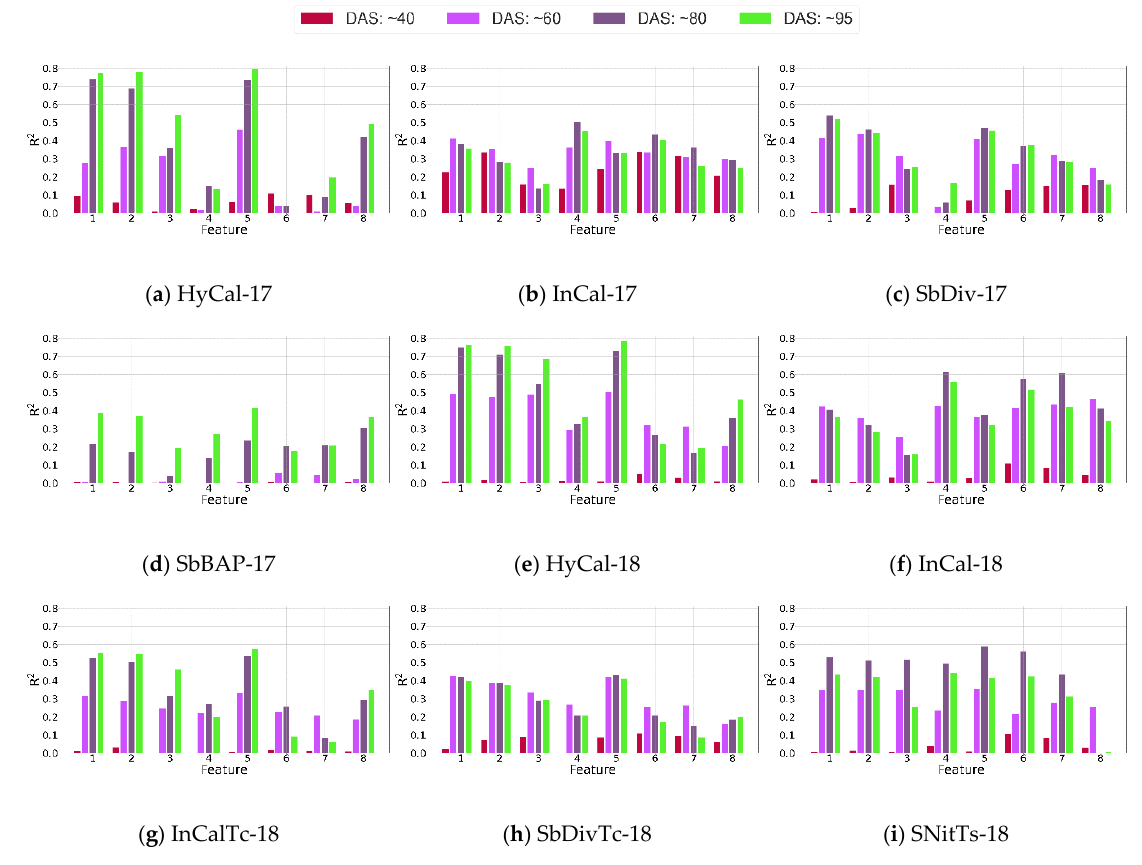
Figure 14. R 2 values of the linear regression-based models developed for the end of season fresh biomass using LiDAR-based features at four stages of growth. Features 1 to 8 represent: #1: 30 th percentile height, #2: 50 th percentile height, #3: 95 th percentile height, #4: coefficient of variation of height, #5: volume, #6: canopy cover (threshold = 0.1), #7: canopy cover (threshold = 0.3), #8: canopy cover (threshold = 0.5).